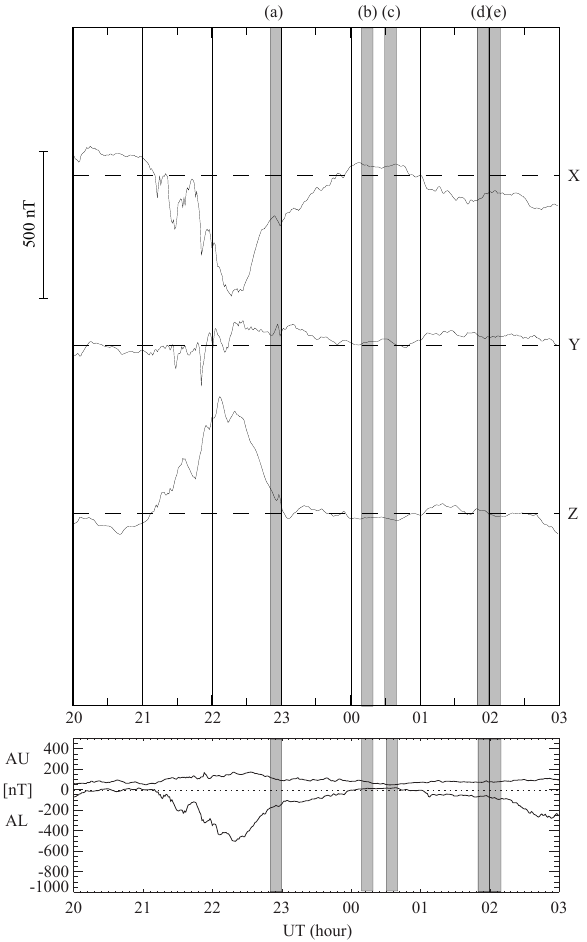
Fig. 3. Ground-based magnetometer data at Tromsø (upper) and the AU − AL index (lower) during our